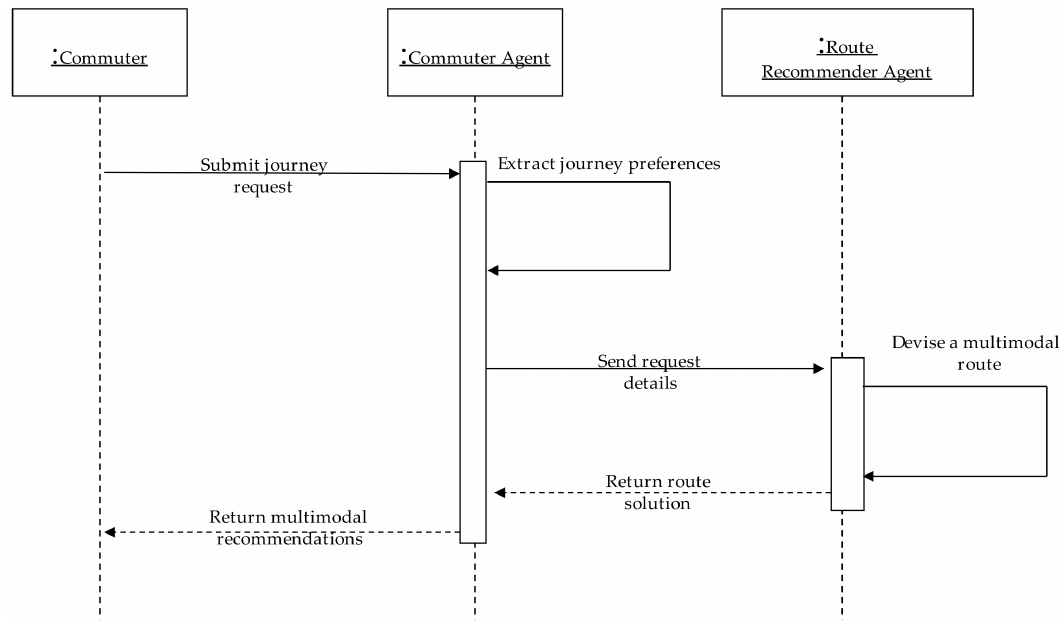
Figure 4. A commuter journey request message